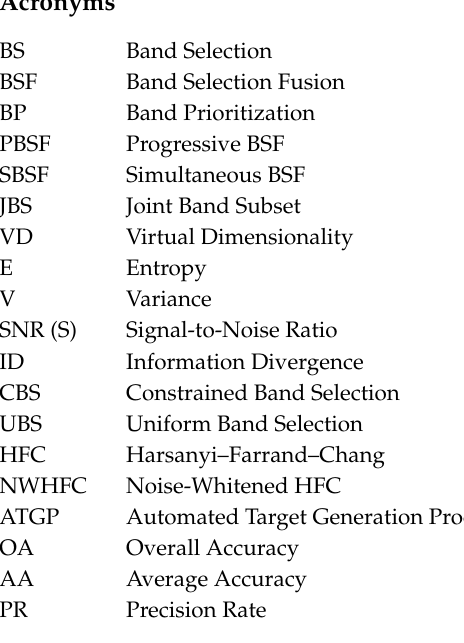
(b) Ground truth map with class labels Figure A2. Purdue’s Indiana Indian Pines scene. A.3. AVIRIS Salinas Data